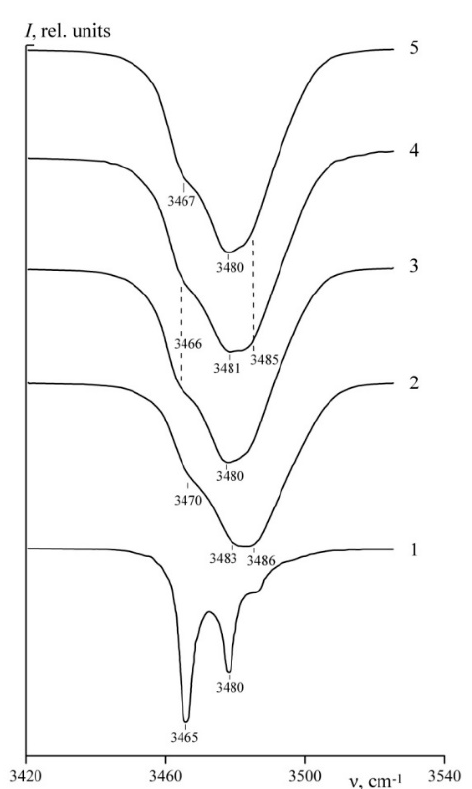
Figure 7. IR absorption spectra of crystals SLN (1), CLN (2) and LiNbO 3 :B (0.55 (3), 0.69 (4), 0.83 (5), mol%). The figure is reproduced with the permission of Pleiades Publishing from the paper N.